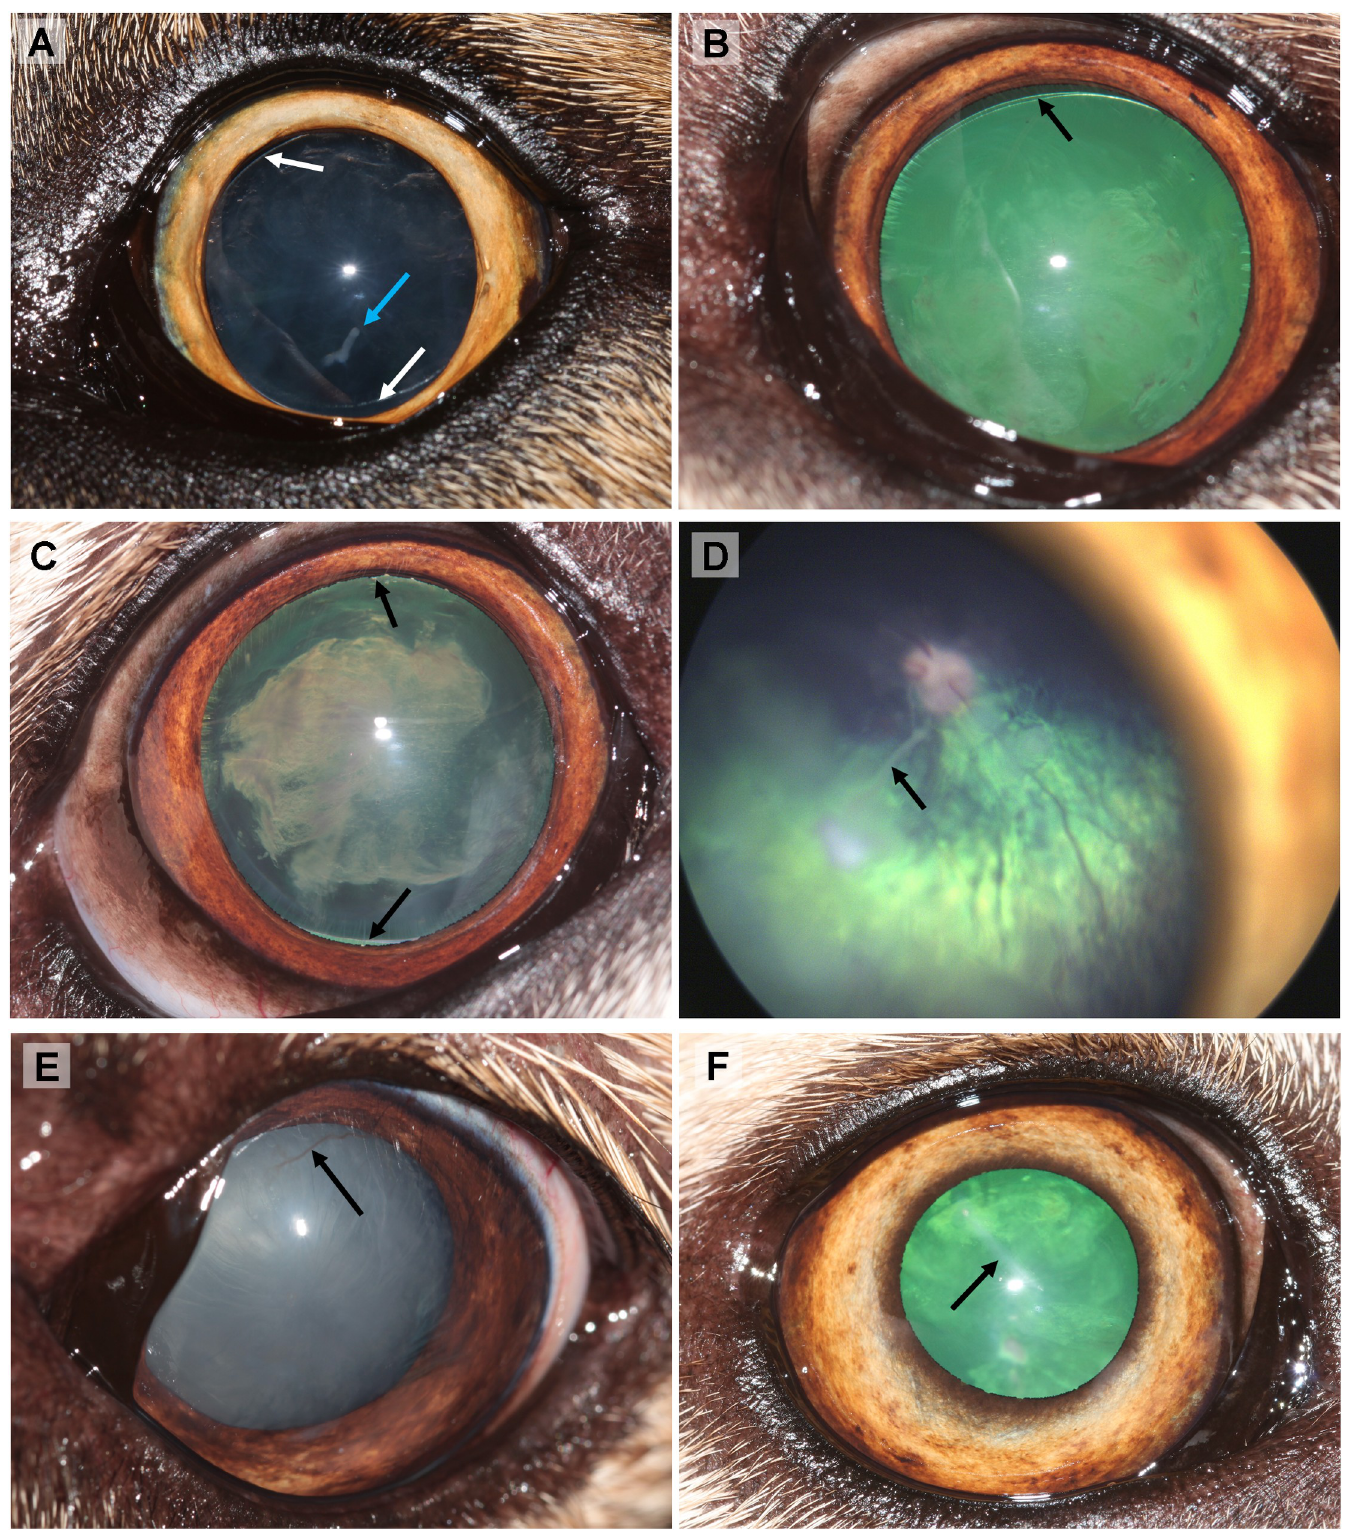
Fig 4. Ocular defects associated with oculoskeletal dysplasia (OSD) in Northern Inuit Dogs (NID). (A) An incipient cataract and lens coloboma (10–12 o’clock and 5–6 o’clock; white arrow) in the left eye. A vitreal tag (blue arrow) on the posterior lens capsule consistent with persistent hyaloid artery remnants is also present (Dog 3,